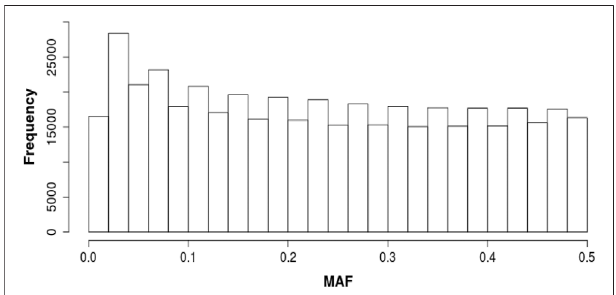
FIGURE 1 | Distribution of minor allele frequencies